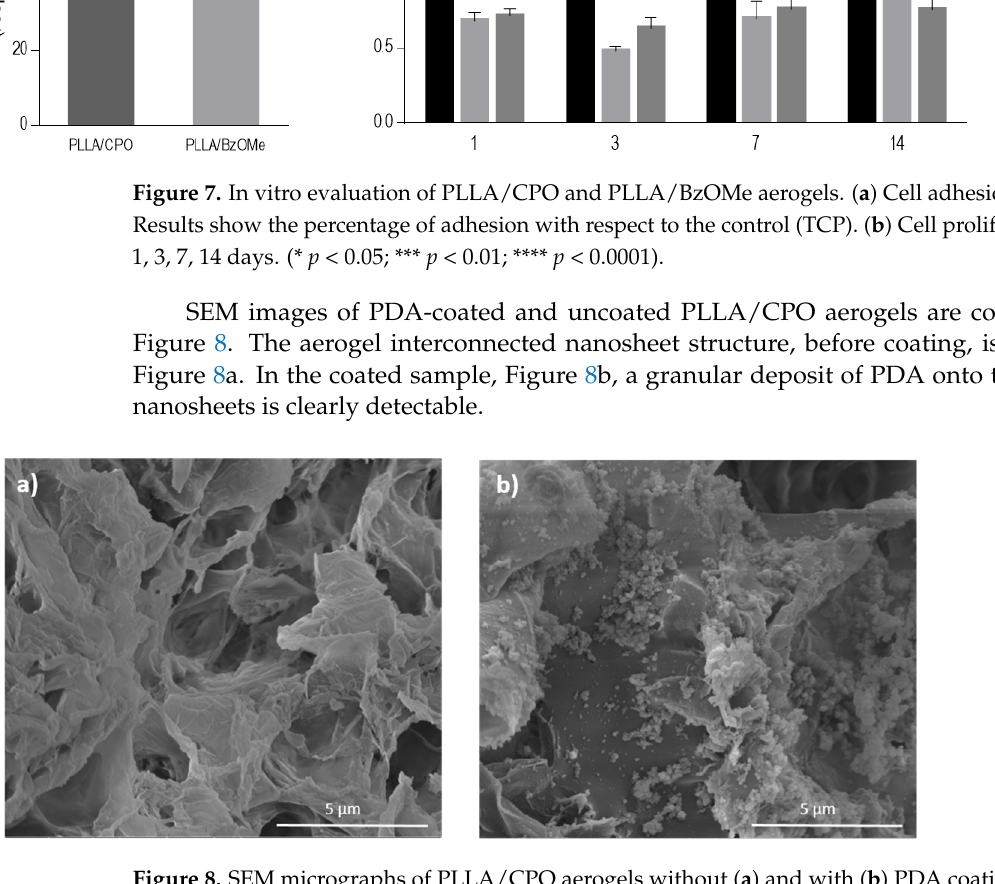
Figure 9. In vitro evaluation of PLLA/CPO and PDA-coated PLLA/CPO aerogels. ( a ) Cell adhesion after 24 h. Results show the percentage of adhesion with respect to the control (TCP). ( b ) Cell pro- liferation after 1, 3, 7, 14 days. (* p < 0.05; ** p < 0.01; *** p < 0.001; **** p < 0.0001). These results are not surprising, considering the biocompatibility of the used pro- teins ascribable to their peculiar chemical composition and macro-structure [47] that both actively influence the in vitro regulation of basic cellular interactions with the substrate. It is worth noting that PLLA has been widely studied as an inert biomaterial for different material applications [48]. The peculiar porous structure of PLLA aerogels, just alone, may contribute to the creation of a friendly environment to promote cell attach- ment and proliferation, as confirmed by reported in vitro results (Figure 7). In this con- text, the presence of the one-dimensional phases of PDA onto the aerogel porous surface allows the exposure of bioactive signals that can favorably modulate in vitro cellular behavior. This may be ascribable to multiple properties of PDA in terms of hydrophilicity and bioelectrical properties, singularly investigated in other studies on similar substrates [49,50]. Based on these results, this preliminary study could be propaedeutic to the design of more efficient electro-conductive scaffolds for specialized tissues with bioelectrical func- tionalities (i.e., muscles and nerves). With this perspective, a more accurate tuning of synthesis conditions may offer a concrete opportunity to reach a right balance between